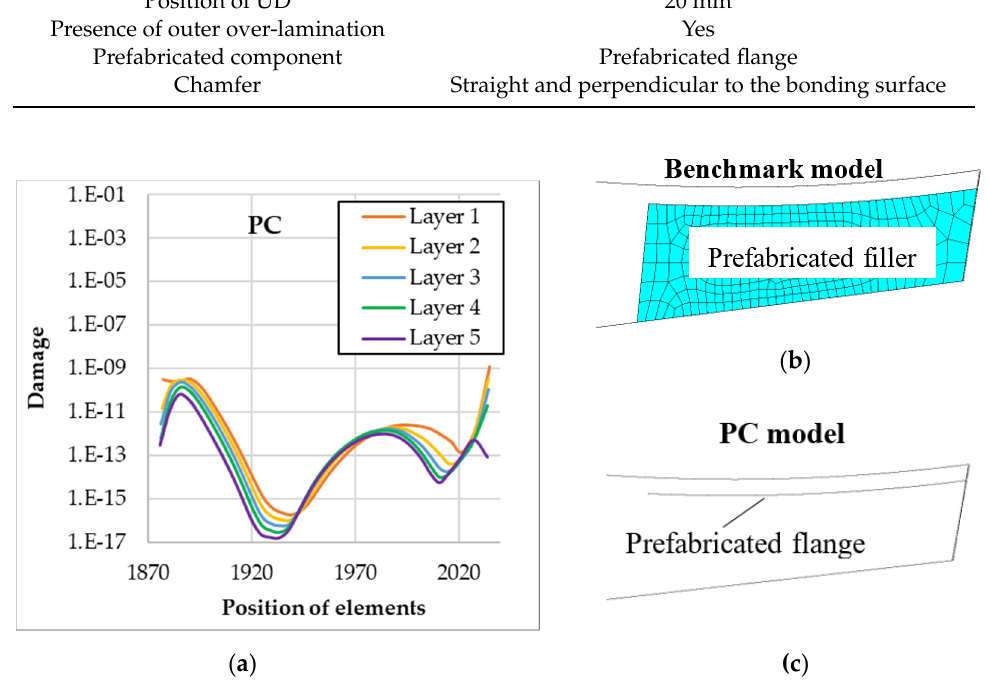
Figure 19. Damage of the PC model and difference between the two models: ( a ) Prefabricated filler in the benchmark model; ( b ) Prefabricated flange in the PC model.